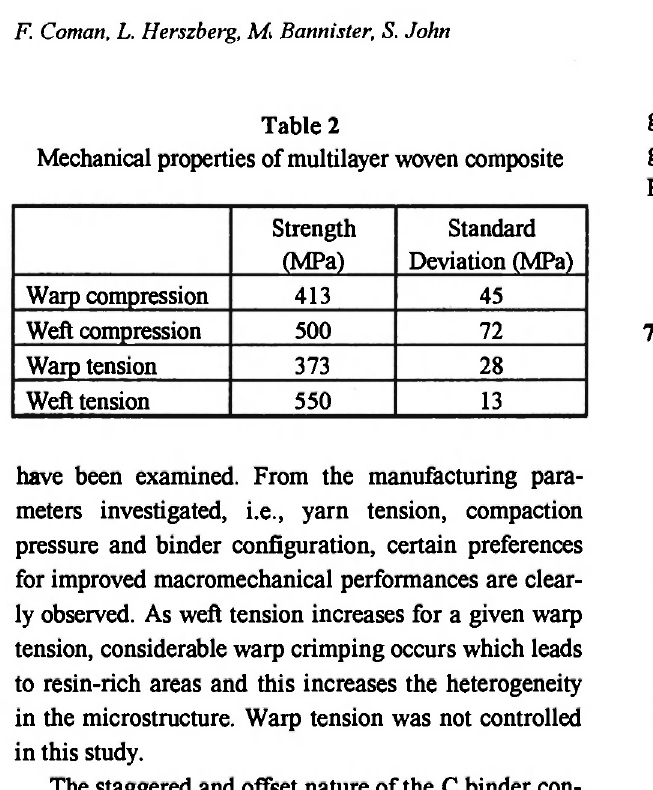
graphs. We would also like to acknowledge with gratitude the assistance of A. Nicolaidis and